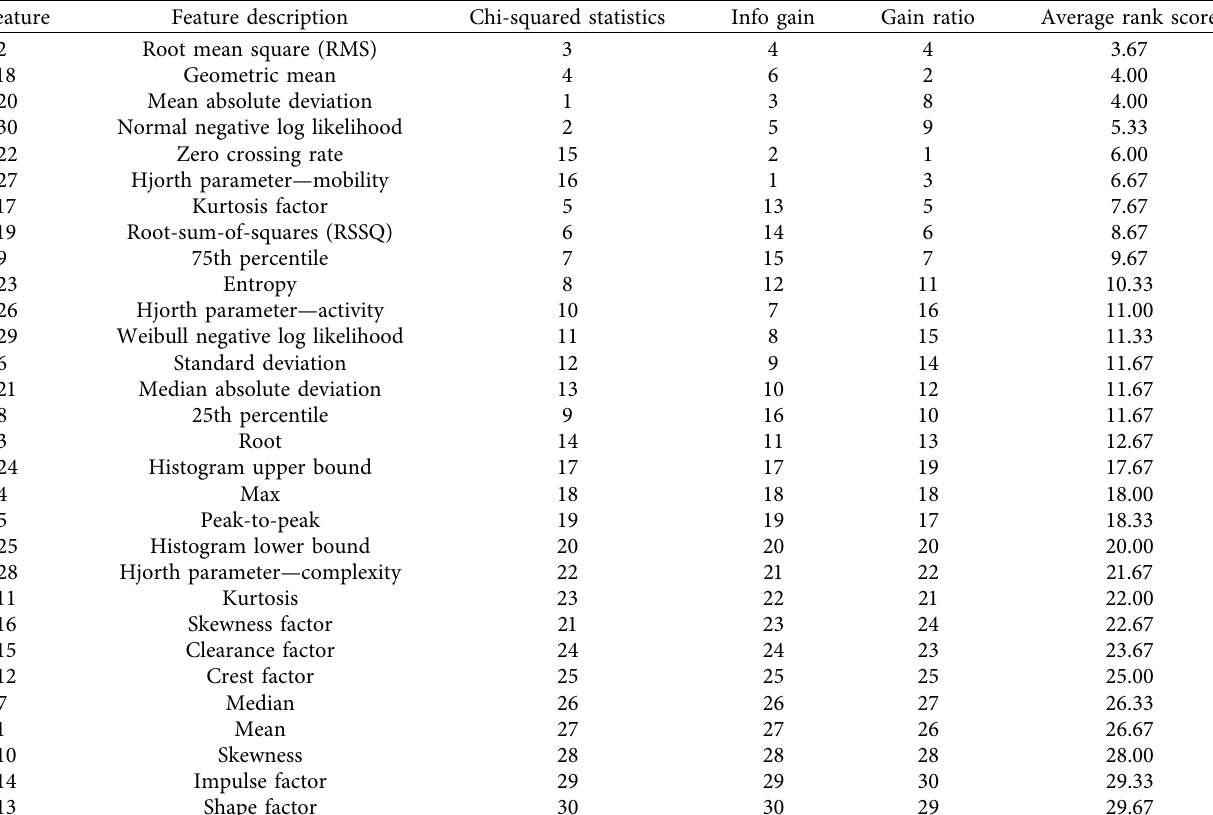
Table 6: Feature ranking of statistical features for dataset